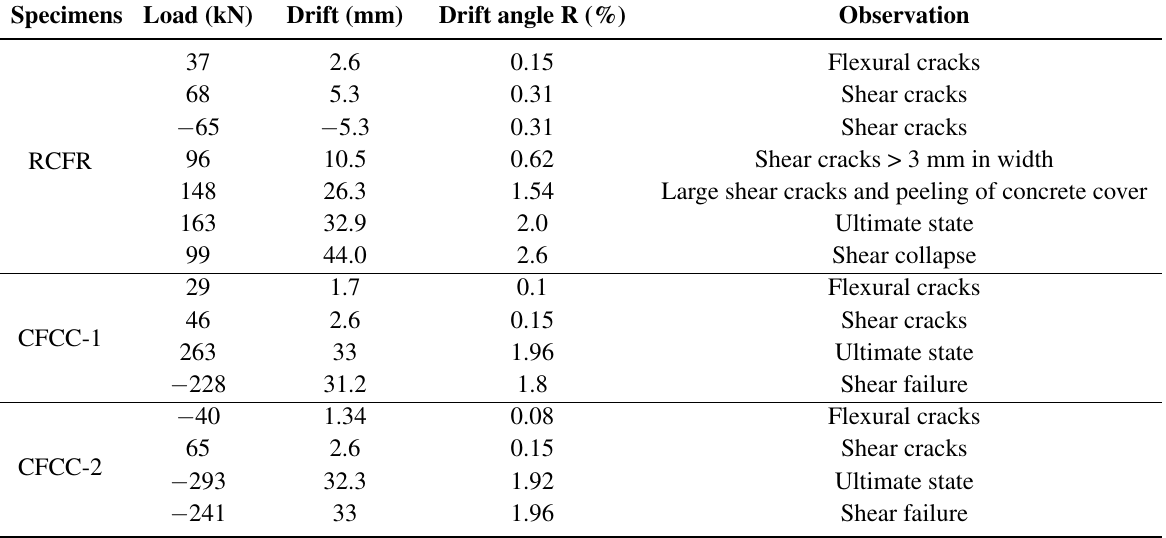
Table 5. Results of the mechanical loading tests for the specimens.